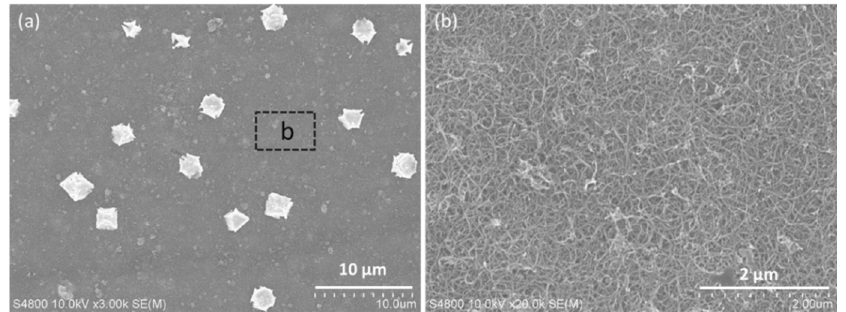
Figure 6. ( a ) SEM image of the surface of the SrGO membranes after filtration of copper nitrate solution under electrochemical assistance at 2.0 V; ( b ) High-resolution SEM image of the area marked in a.